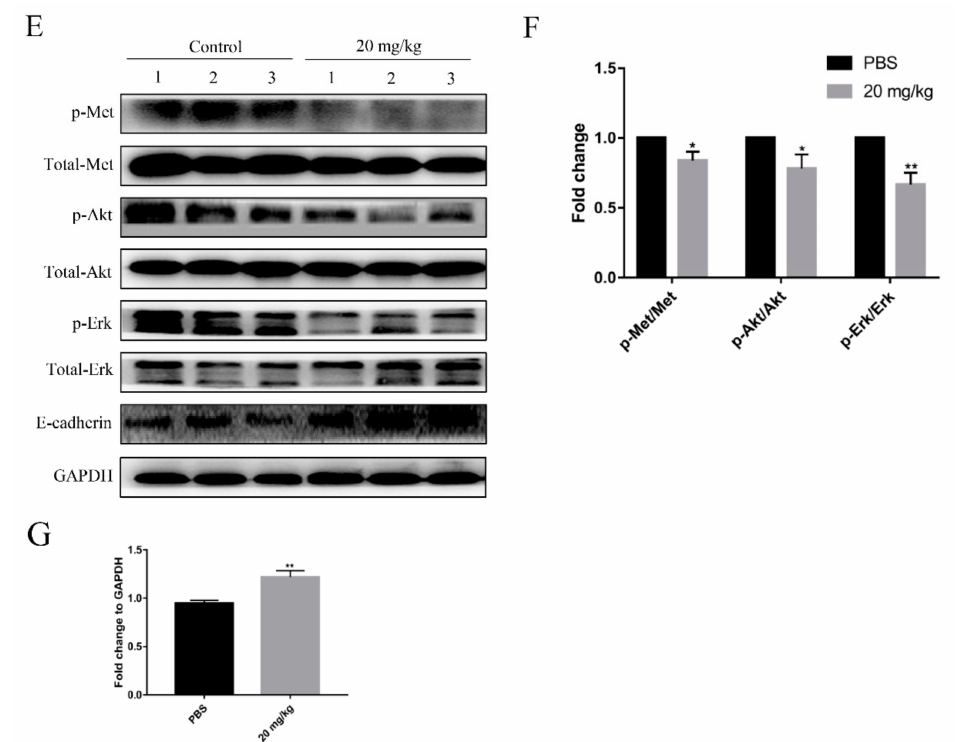
Figure 9. Inhibition of MKN-45 tumor growth by various treatments in vivo . Nude mice with tumor xenografts established by subcutaneous injection of MKN-45 cells were treated daily for four weeks with vehicle (0.2% DMSO) or Crizotinib (50 mg / kg) by gavage, and the tested peptide or vehicle (PBS) were subcutaneously injected twice a day for four weeks. ( A ) Images of the tumors of each group at the end of treatments. ( B ) The mean tumor volume of each group during the experimental period. ( C ) Tumor wet weights of each group were measured after the animals were sacrificed. Data are shown as mean ± SD obtained from each group (n = 5–6). * p < 0.05 vs vehicle (PBS) group, ** p < 0.01 vs vehicle (PBS) group, ### p < 0.001 vs vehicle (DMSO) group, unpaired t -test. ( D ) IHC evaluation of ki67 expression for the vehicle (PBS) and 20 mg / kg groups. ( E ) Inhibition of c-Met phosphorylation and downstream signaling molecules in MKN-45 xenografts by CM 7. ( F , G ) Quantitative statistics for the fold change of corresponding proteins in Figure 8E. Results are presented as mean ± SD (n = 3). * p < 0.05, ** p < 0.01 vs control, unpaired t